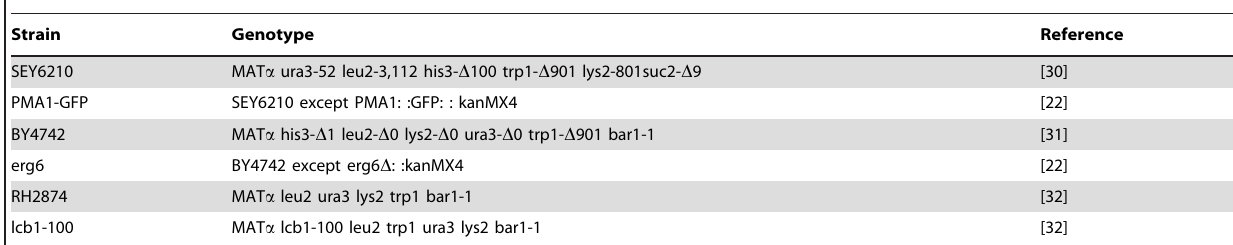
Table 1. Yeast strains used in this study.